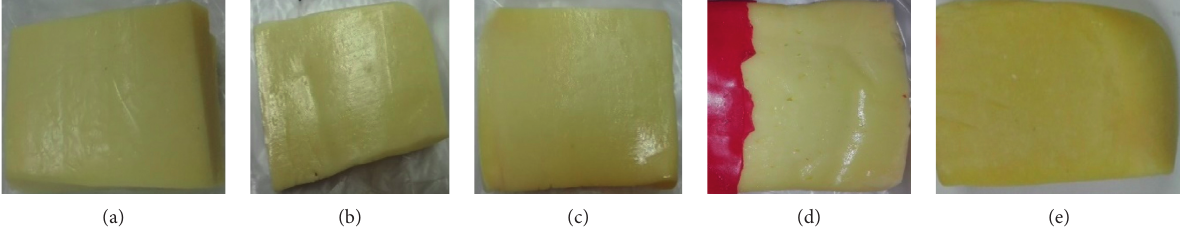
Figure 6: Appearance of cheeses coated with antimicrobial edible coatings incorporated with (a) solution 1(0.250 g/L Delvocid), (b) solution 2 (0.275 g/L Delvocid), and (c) solution (0.300 g/L Delvocid), compared with commercial paraffin coating (d) and uncoated cheese (e) at 0 day storage.